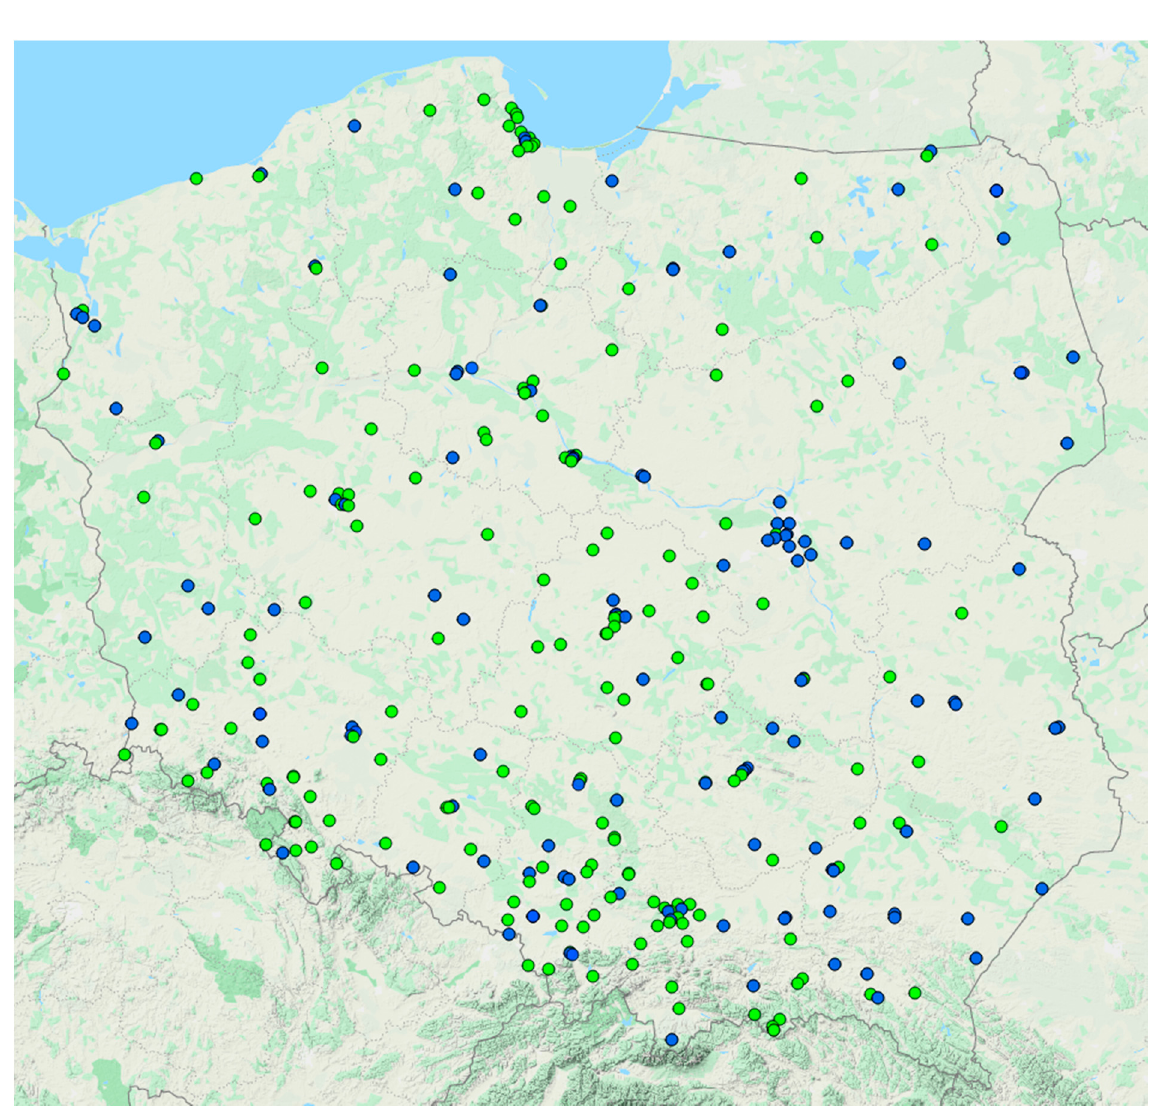
Figure 2. Locations of air quality monitoring stations in Poland. Blue dots represent PM 2.5 and PM 10 monitoring stations. Green dots represent the PM 10 monitoring station. Table 2. General characteristics of PM 10 monitoring stations operating between years 2016–2019 in Poland. Data for PM 10 Monitoring Stations (Means for Years 2016–2019)